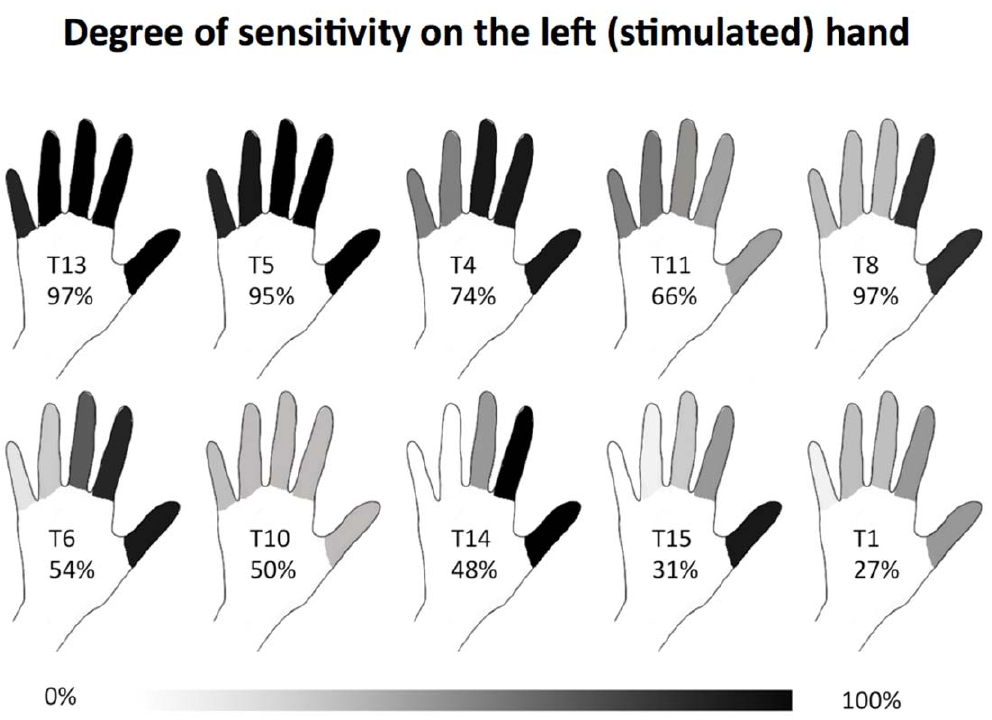
Figure 1. Subjective rating of tactile sensation on the stimulated hand in the S 2 group. Percentages indicate the strength of tactile sensation on each finger compared to the face and is represented as a gray scale from white (no sensation) to black (complete sensation, as on the face). The hands are sorted from the top left to the bottom right by the mean values, which are added to each hand numerically.